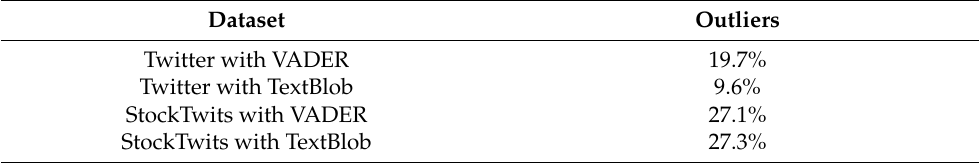
Table 4. Outlier